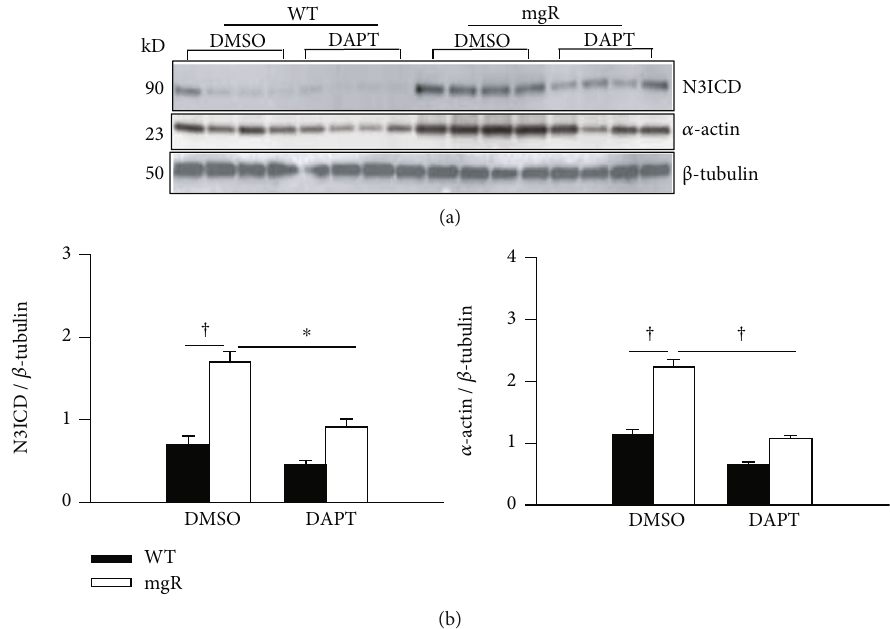
Figure 5: DAPT treatment blocked Notch3 activation and reversed SMC phenotype in the aorta of Fbn1 mgR/mgR (mgR) mice. (a) Aortic protein from WT and mgR mice treated with DMSO and DAPT ( n = 5 -6/group) was extracted at PD 42. The levels of N3ICD and the smooth muscle cell di ff erentiation marker, α -actin, were examined by Western blot analysis. (b) The bar graph shows relative active Notch3 (N3ICD) and α -actin levels in the aortic tissue. ∗ P < 0 : 01 and † P < 0 : 001 ; ANOVA with Tukey-Kramer post hoc test.